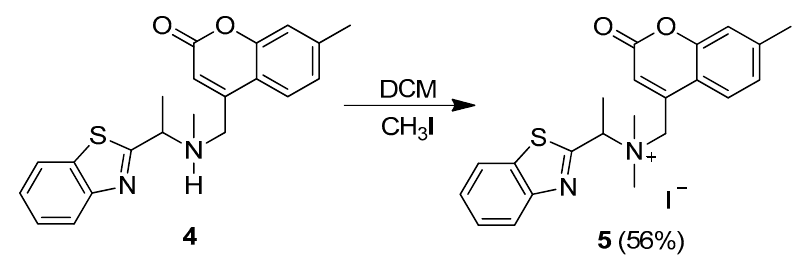
Figure 2. Design strategy of probe 5.